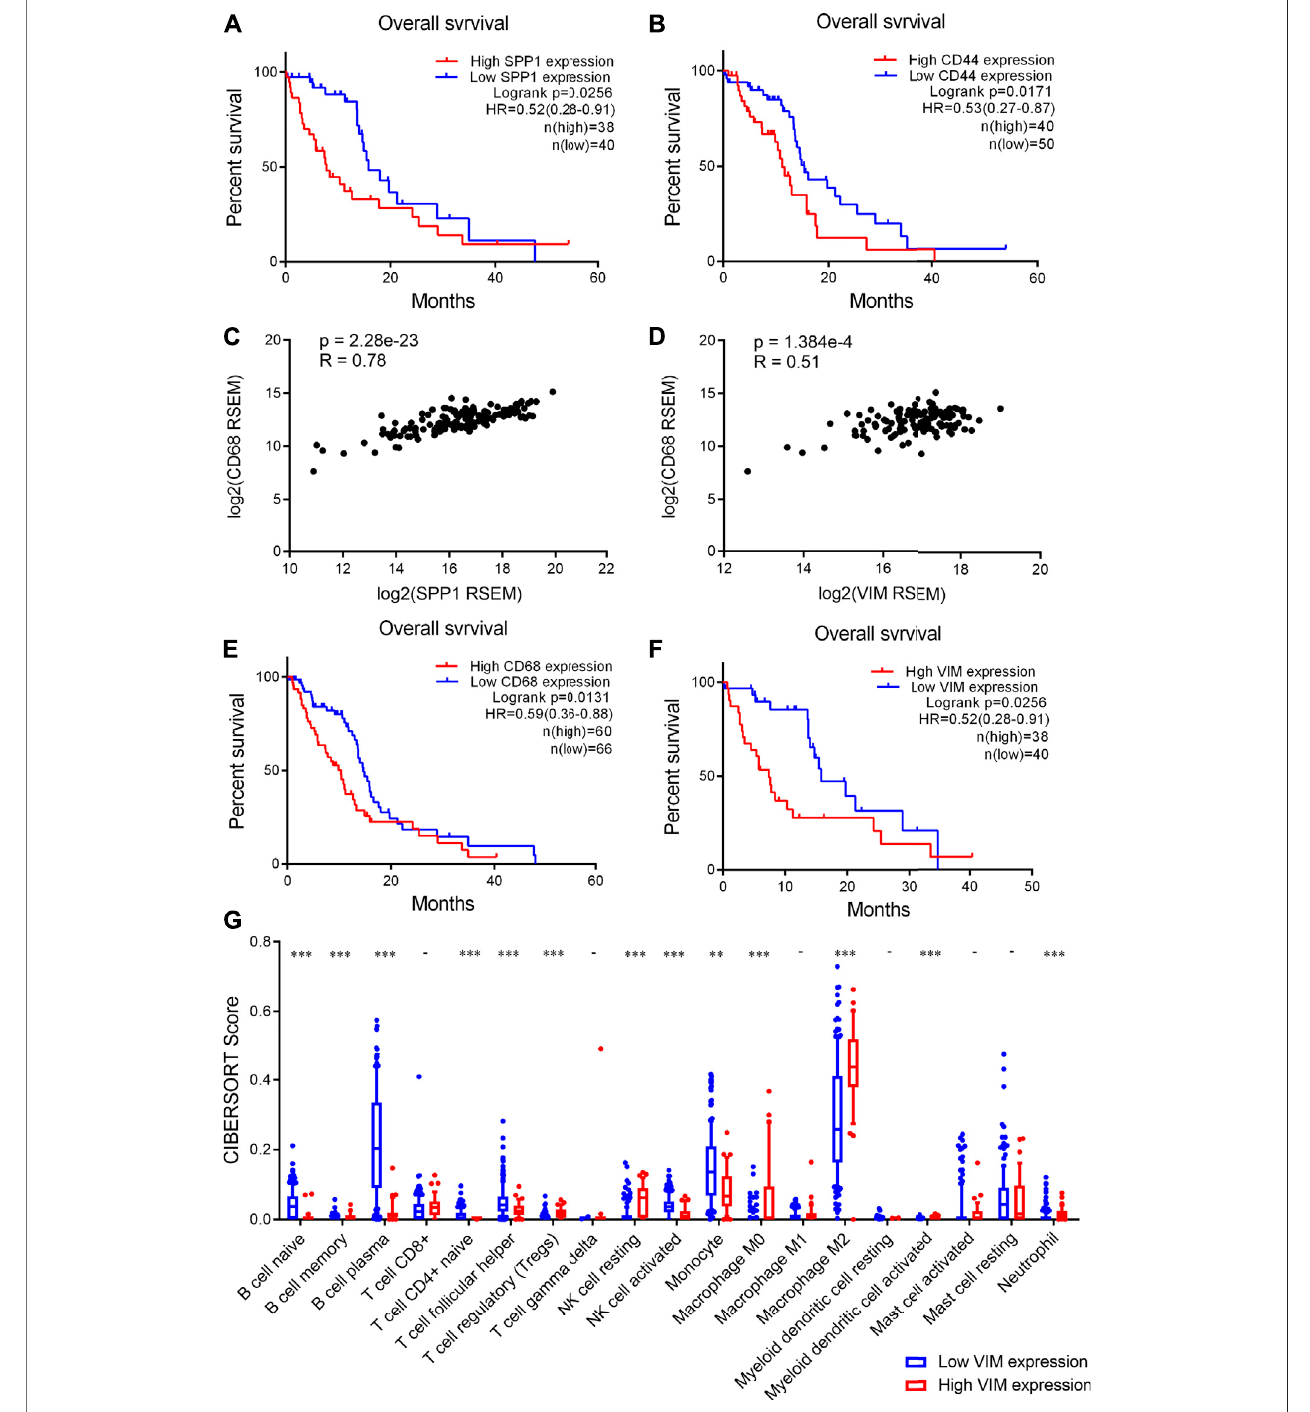
FIGURE 6 | High CD44 and SPP1 expression correlated with increased in fi ltration of macrophages and poor prognosis of glioma patients. (A-B) High SPP1 and CD44expressioncorrelatedwithpoorprognosisofgliomapatientsrespectively.Log-ranktest, p < 0.05wasconsideredsigni fi cant. (C-D) Positivecorrelationsbetween CD68 and SPP1 or VIM expression levels in human glioma tumors. p < 0.05 was considered signi fi cant. (E-F) High CD68 and VIM expression correlated with an unfavorable prognosis of glioma patients. Log-rank test, p < 0.05 was considered signi fi cant. (G) Box plot showing the scores of in fi ltrated immune cell subtypes betweenglioma tumors with lowandhigh VIMexpression.The x axisrepresentsthe19subtypes ofin fi ltrated immune cells, the y axisrepresentsthescoresofin fi ltrated immune cells. Wilcoxon ’ s test, **, p < 0.01; ***, p < 0.001.